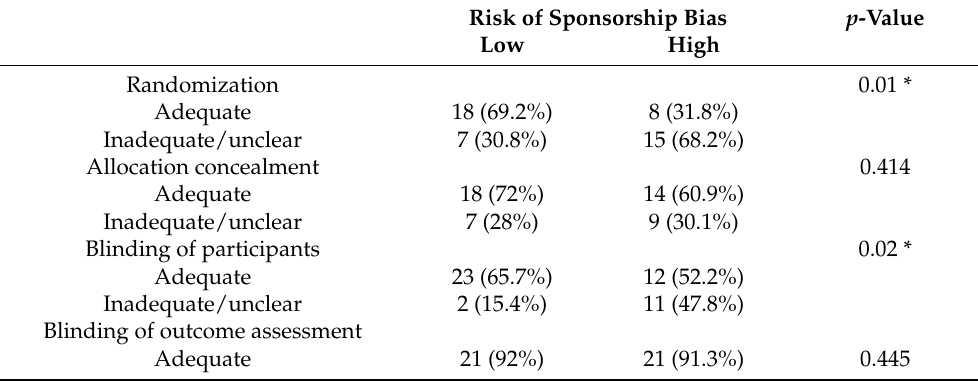
Table 2. Comparison of qualities between high-risk trials and low-risk